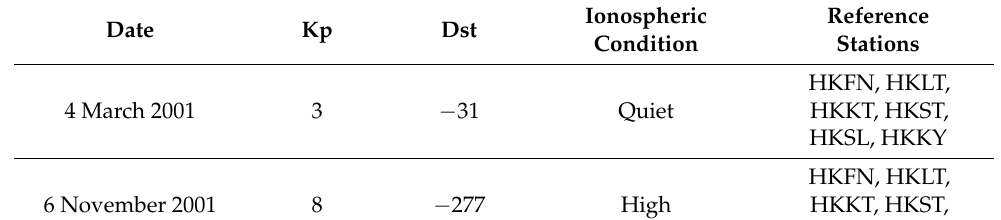
Table 1. Details of testing observation data.